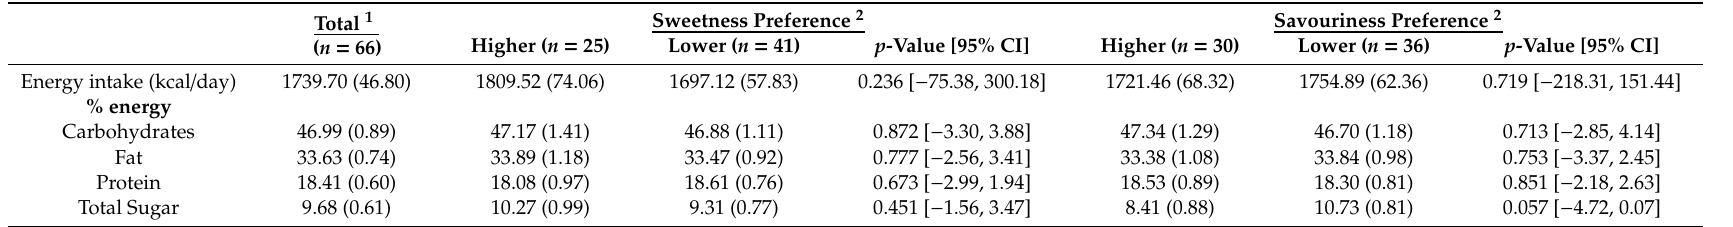
Table 2. Associations between sweetness and savouriness preferences with energy intake and proportion of energy intake (%energy) from macronutrients and total sugar ( n =